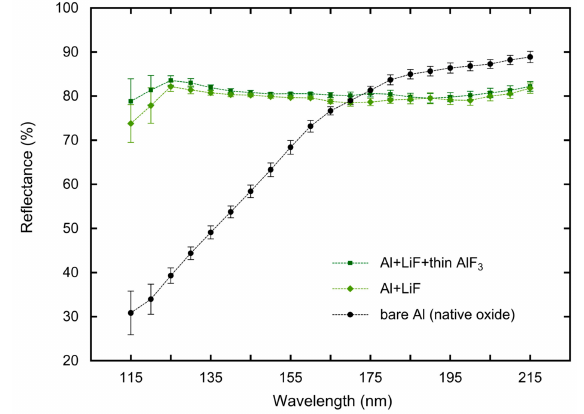
Figure 6. The measured FUV reflectance of Al mirrors protected with 18 nm ALD LiF films deposited at 100 ◦ C. One sample was coated with an additional 2 nm of ALD AlF 3 as an initial test of encapsulation strategies to limit environmental sensitivity of the underlying